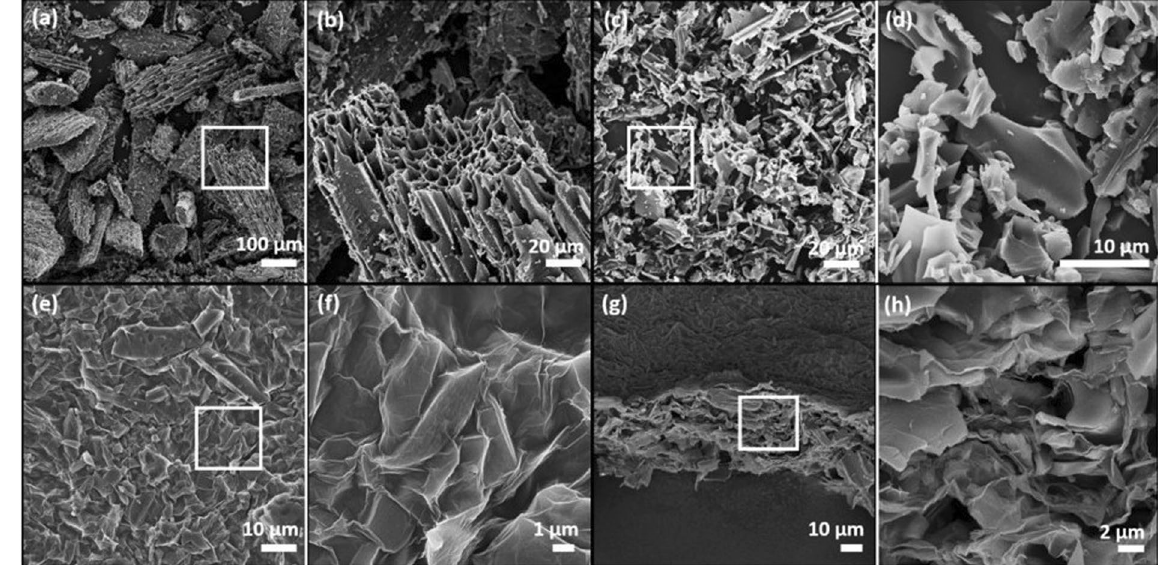
Figure 2. ( a ) The SEM image of as-received biochar (BC-pristine) and ( b ) a magnified image of the small region identified by the white rectangular box in ( a ). ( c ) The SEM image of oxidized biochar (BC-treated) and ( d ) a magnified image of the small region identified in ( c ). ( e ) The SEM image of the top of a BC-RGO electrode and ( f ) a magnified image of the small region identified in ( e ). ( g ) The SEM image of the BC-RGO cross section and ( h ) a magnified image of the small region identified in ( g ).